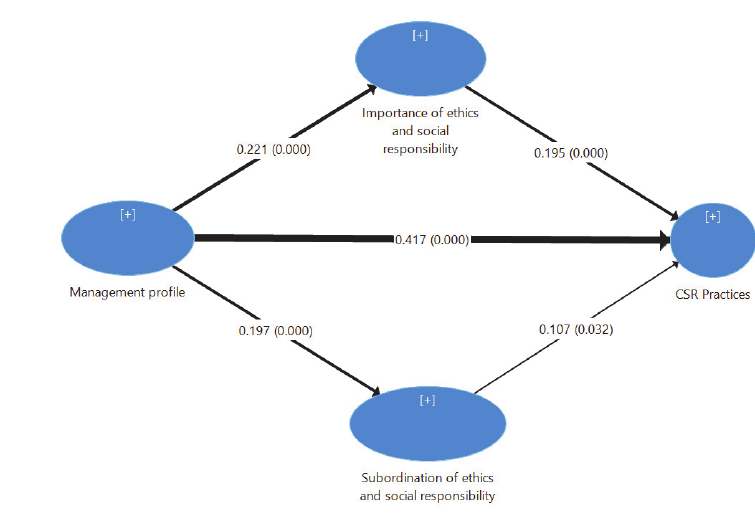
Fig. 2. Hypothesis test result (Boostrap out of Smart PLS)